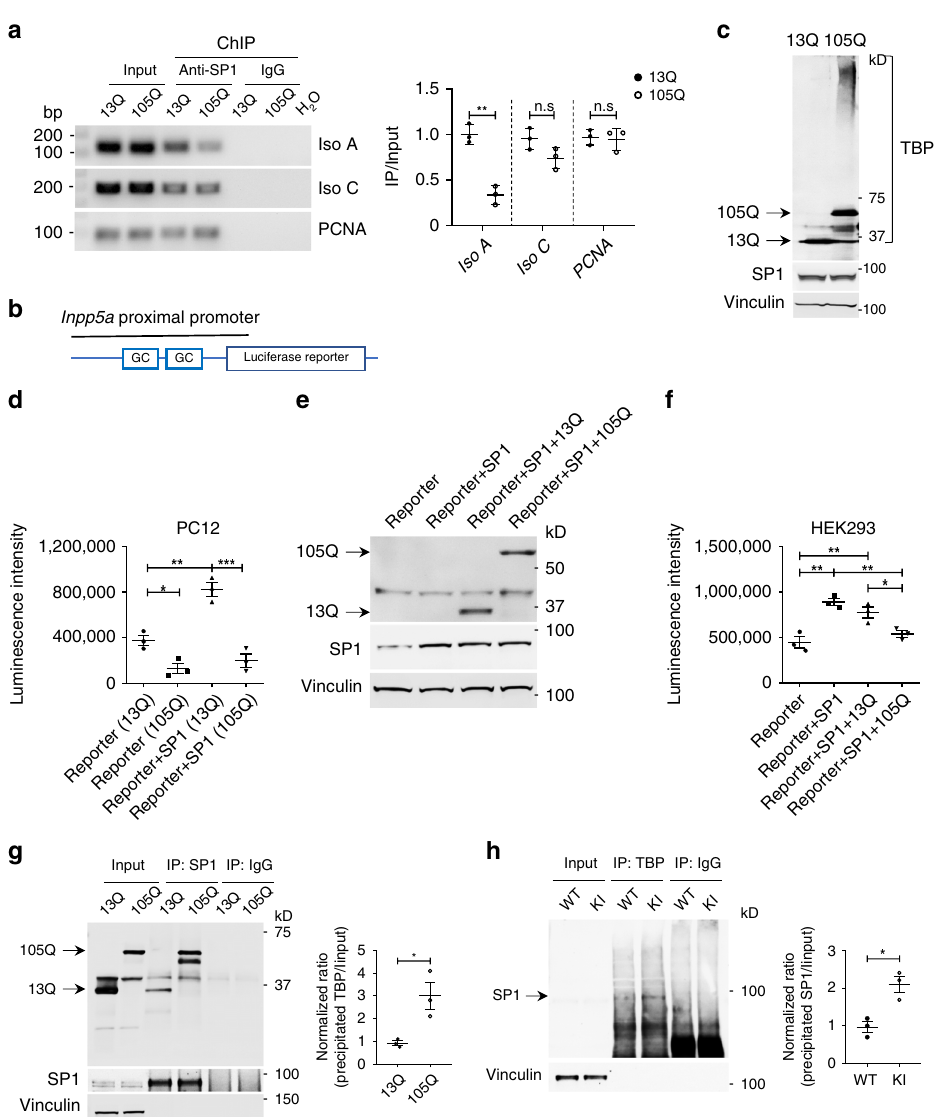
Fig. 5 Expanded polyQ affects the interaction between TBP and SP1 and impairs the transcription of Inpp5a . a Chromatin immunoprecipitation (ChIP) assay of SP1 association with the Inpp5a promoter in HEK293 cells transfected with TBP -13Q or TBP -105Q. Cross-linked chromatin materials were immunoprecipitated (IP) by anti-SP1 and were subjected to polymerase chain reaction (PCR) with primers speci fi c for the promoter region of Inpp5a and PCNA (proliferating cell nuclear antigen), which served as a control. Representative agarose gel electrophoresis images of PCR products (left). Quanti fi cation of the ratios of immunoprecipitated products to input is presented (right). T = 7.757, ** P = 0.0015 (unpaired t test). b Schematic map of a luciferase construct for reporter assay. c Western blotting showing the expression of SP1 and TBP in transfected PC12 cells. d Luciferase activity analysis of stable PC12 cell lines expressing TBP -13Q or TBP -105Q with or without transfected SP1 . Luminescence intensity was analyzed with one-way ANOVA followed with Tukey ’ s multiple comparisons test. F = 35.19, * P < 0.05, ** P < 0.005, *** P < 0.0005. e Western blot analysis of HEK293 cells transfected with SP1 and TBP -13Q or 105Q. f Luciferase activity analysis of transfected HEK293 cells. Cells transfected only with Inpp5a promoter reporter were used as control. Luminescence intensity was analyzed with one-way ANOVA followed with Tukey ’ s multiple comparisons test. F = 16.39, * P < 0.05, ** P < 0.005. g Co-immunoprecipitation of transfected SP1 with TBP -13Q or TBP -105Q in HEK293 cells showing an increased interaction of SP1 with soluble TBP-105Q compared to TBP-13Q. Right panel showing the ratio of precipitated TBP to input. T = 3.518, * P = 0.0245 (Student ’ s t test). h TBP antibody immunoprecipitation of mouse cerebellar lysates also showed that more SP1 was coprecipitated in KI mice than in WT mice. One-month-old mice were used. Right panel showing the ratio of precipitated SP1 to input. T = 4.389, * P = 0.0118 (Student ’ s t test). Data are represented as mean ± SEM. Source data and full blots are provided as a Source Data fi